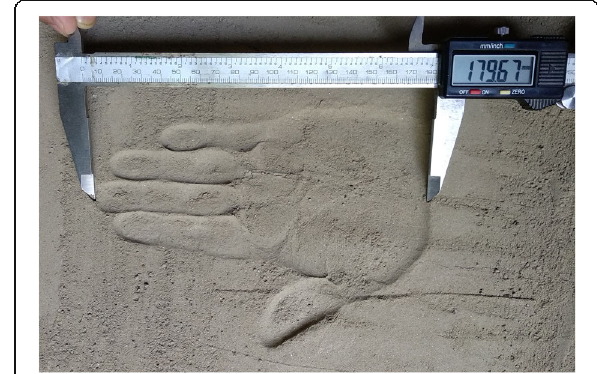
Fig. 1 Technique of taking 3 rd digit length or hand length from